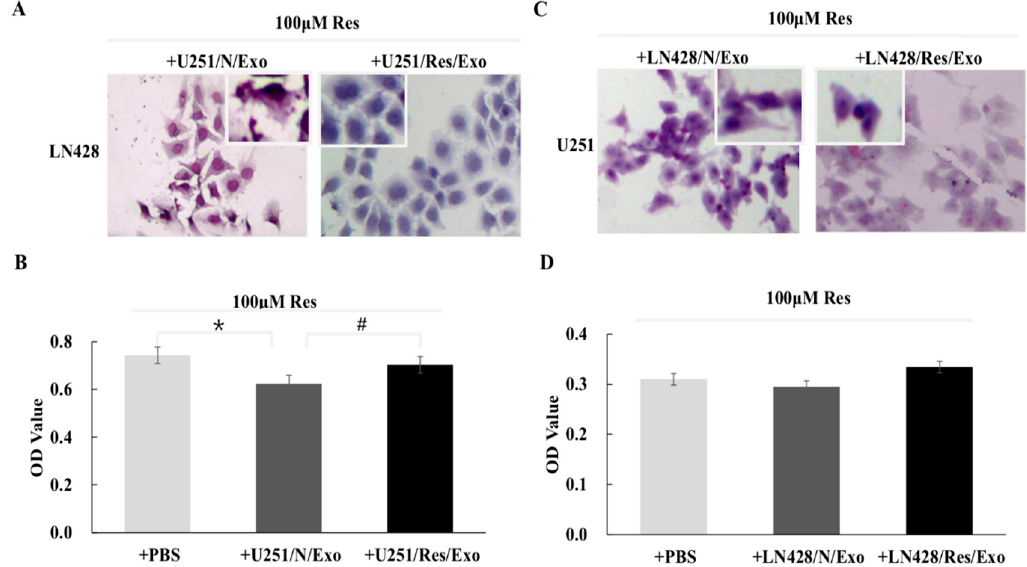
Figure 3. Impacts of exosomes from different origins. Hematoxylin and eosin staining and MTT assay were performed on the cell-bearing coverslips to assess resveratrol sensitivities of LN428 and U251 cells incubated with the exosomes derived from U251 and LN428 without and with resveratrol treatment. Morphology ( A ) and inhibition ratio ( B ) of LN428 cells treated by resveratrol and U251/N/Exo or U251/Res/Exo combination. The insets in ( A ) show the cells with higher magnification ( × 200). *, p = 0.011; #, p = 0.043. Morphology ( C ) and inhibition ratio ( D ) of U251 cells treated by resveratrol and LN428/N/Exo or LN428/Res/Exo combination. The insets in ( C ) show the cells with higher magnification ( × 200). Resveratrol exerts similar growth suppression effects on the three groups ( p >